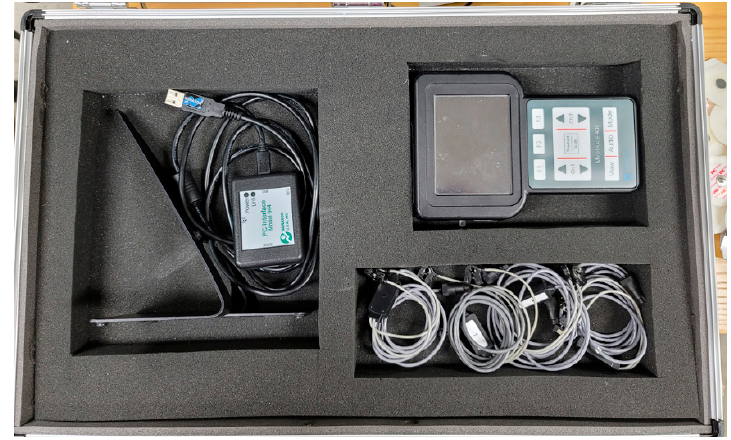
Figure 2. Surface EMG 4-channel wired instrument (MyoTrace 400).